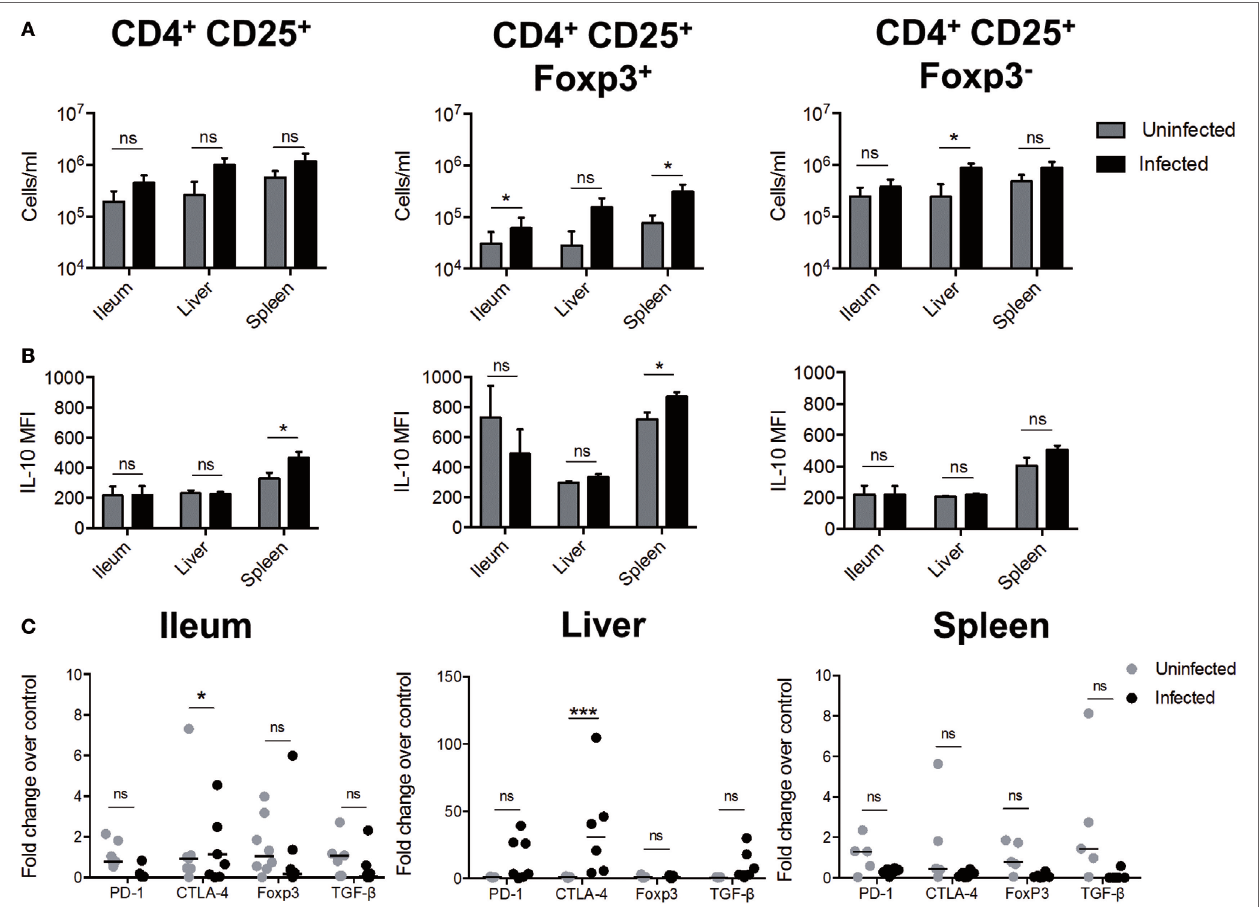
FigUre 3 | S. Typhimurium infection induces the generation of regulatory T cells (Tregs cells). C57BL/6 mice were left uninfected or orally infected with 1 × 10 5 CFU of S. Typhimurium and after 96 h post infection of infection the ileum, liver, and spleen was recovered to detect the presence of Tregs. (a) Quantification of total CD4 + CD25 + ; CD4 + CD25 + FoxP3 + , and CD4 + CD25 + FoxP3 − T cells. (B) Measurement of mean fluorescence intensity (MFI) of IL-10 secretion by flow cytometry in target tissues ex vivo . Gray bars = uninfected; black bars = infected. * P < 0.05, *** P < 0.001 (Student’s t -test). (c) Tregs cells markers expression in target tissues during S. Typhimurium infection. The quantification of messenger RNA (mRNA)-encoding Tregs cells markers were evaluated in target tissues infected by S. Typhimurium, using quantitative real-time RT-PCR at 5 days post infection with specific TAQMAN probes. β 2-microglobulin gene was used as endogenous control. The results are shown as fold change of relative expression, compared with wild-type (WT) uninfected mice ( ΔΔ CT). Statistical analysis was performed using two-way ANOVA with Bonferroni post test (* P < 0.05; ** P < 0.01; *** P <